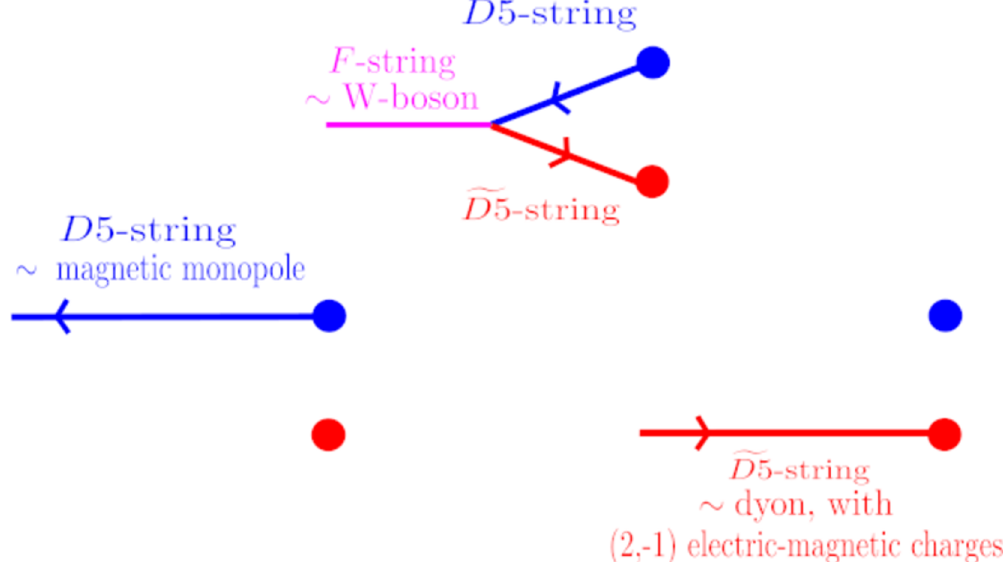
Figure 2 . Splitting of perturbative D7 brane into two cosmic defects (red and blue points). A D5-string (blue) can end on one of the defects, and a D5 with a negative unit of electric charge (red) ( f D5) can end on the other. The F-string (purple) can end on the entire configuration via a string